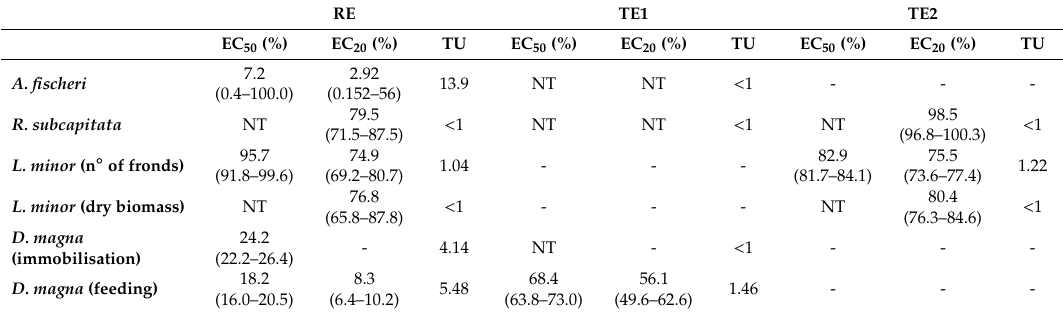
Table 4. Values of TU (toxic units), EC 50 and EC 20 , with 95% confidence limits inside brackets, for all tests performed with the treated e ffl uent samples (TE1 and TE2) and the raw e ffl uent sample